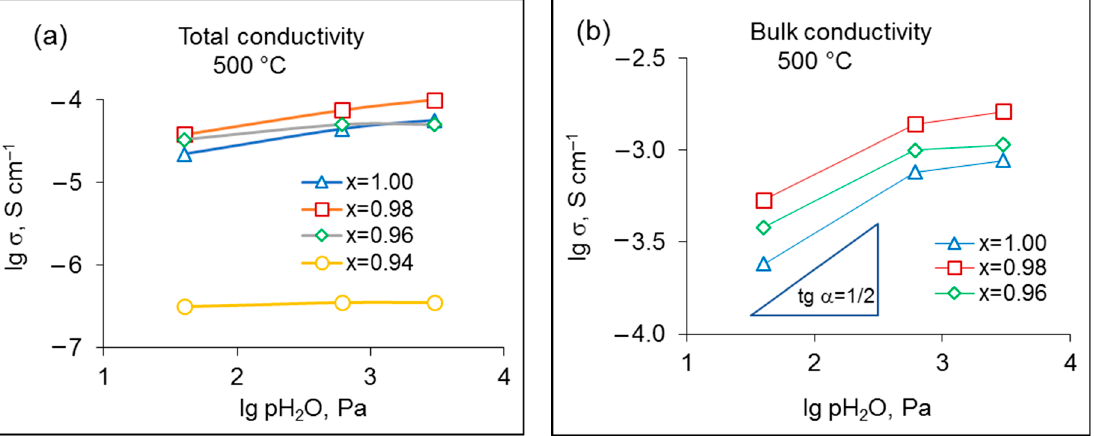
Figure 6. Total ( a ) and bulk ( b ) conductivity of Sr x Zr 0.95 Yb 0.05 O 3– δ samples as a function of pH 2 O at 500 °C. Lines between points are only a guide to the eye.